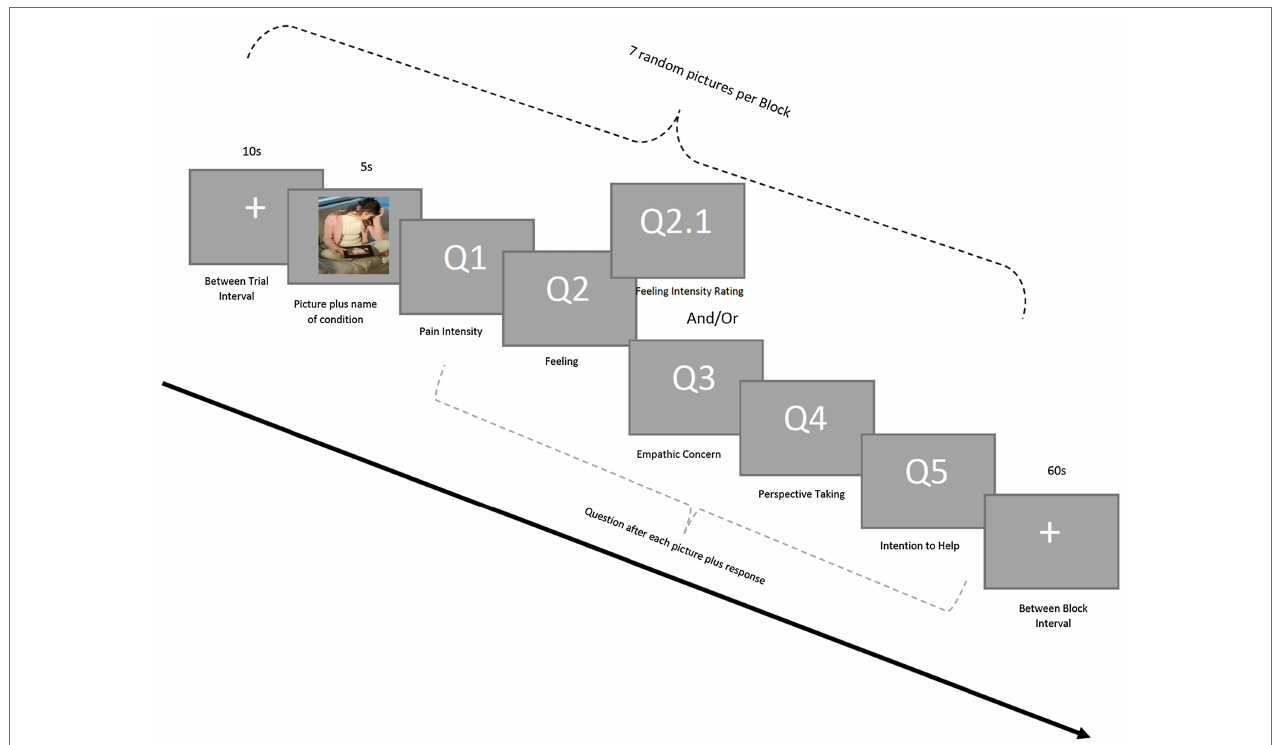
FIGURE 2 | Experimental